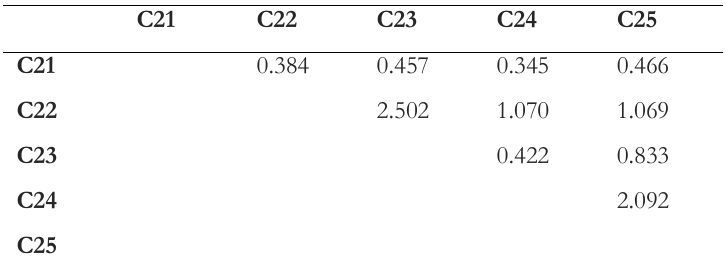
Table 6. Pairwise comparisons of sustainable marketing sub-criteria.